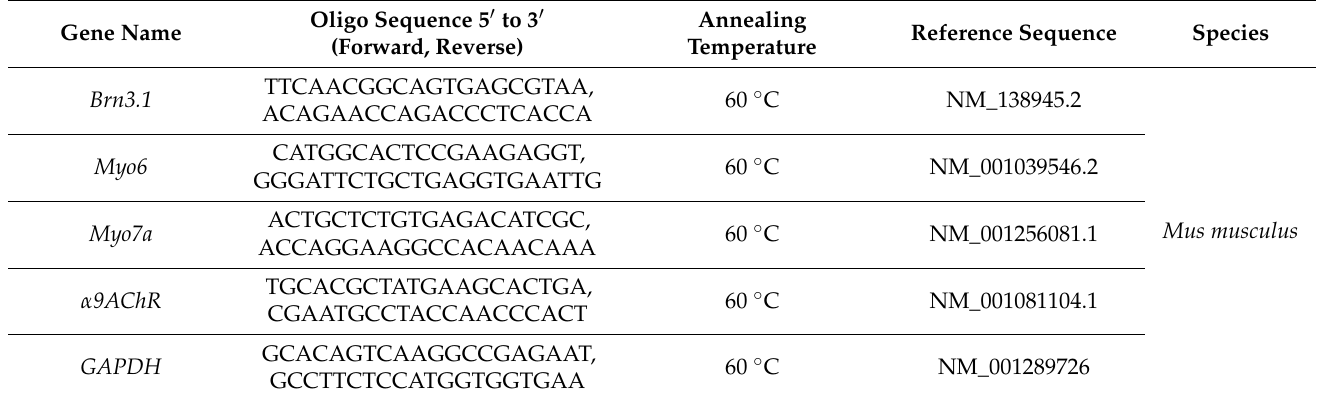
Table 3. Primer used for quantitative real-time PCR to verify